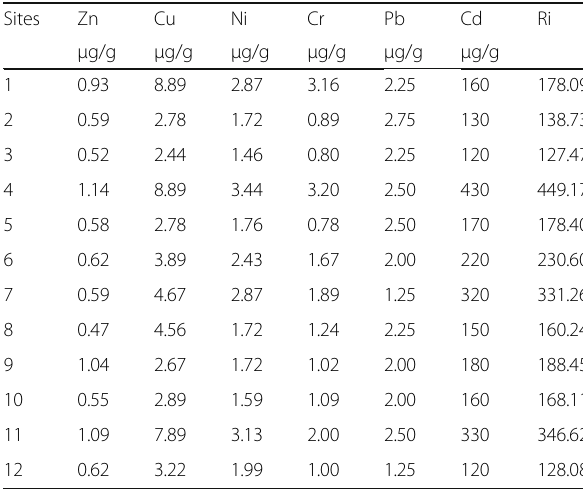
Table 14 Ecological risk factor 2010 Sites